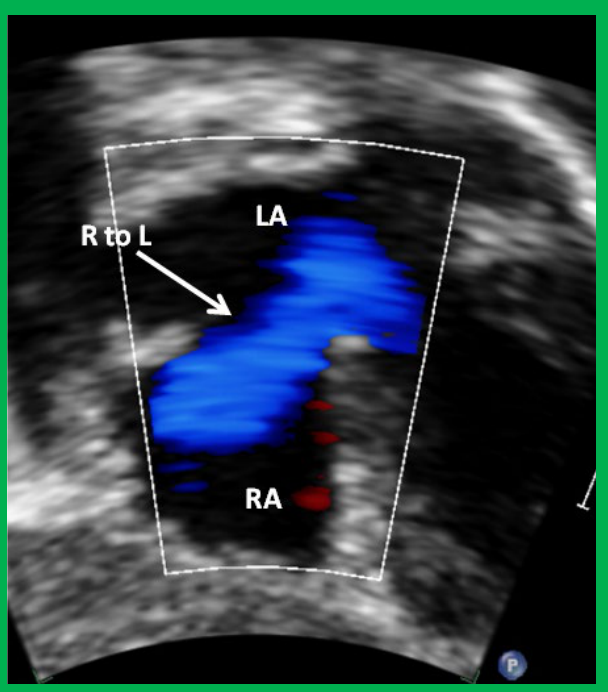
Figure 9. Selected video frame from subcostal view of a patient with tricuspid atresia demonstrating right to left (R to L) shunt (arrow) across the interatrial communication. LA, left atrium; RA, right atrium. Reproduced from Reference [29].